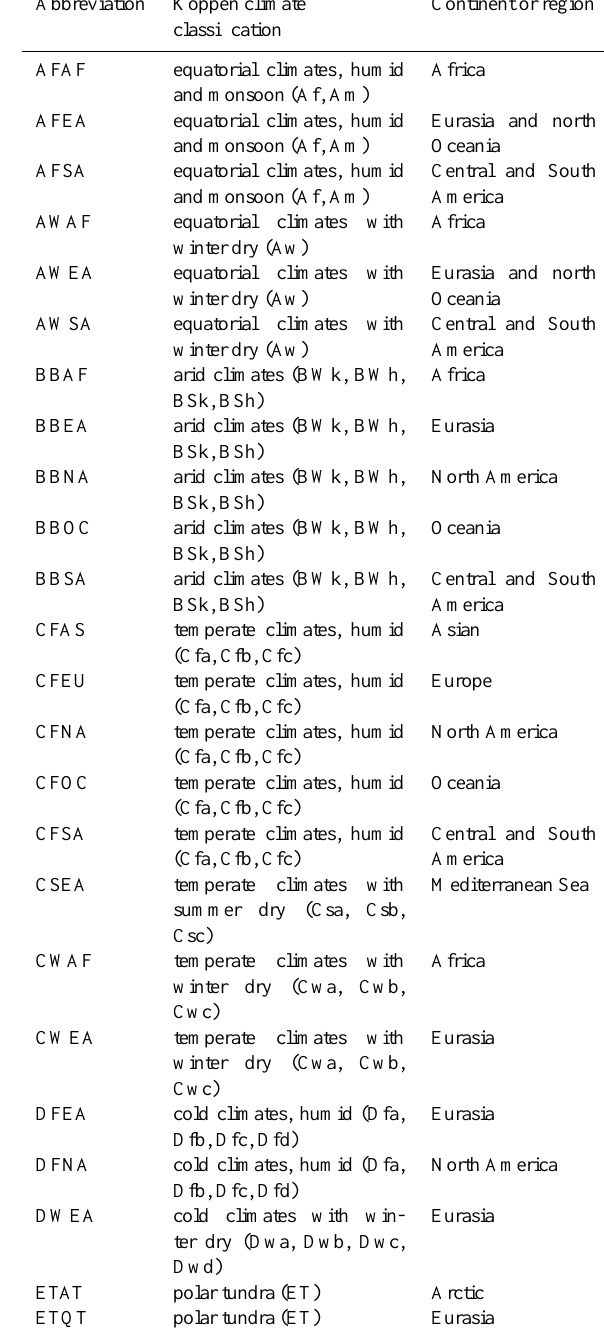
Table 1. List of regions referred to this paper. Abbreviations consist of the first two letters of Köppen climate classification (indicating climate) and two letters to identify the continent or region. For ex- ample, AFAF is first group (A, equatorial) humid (F) in Africa